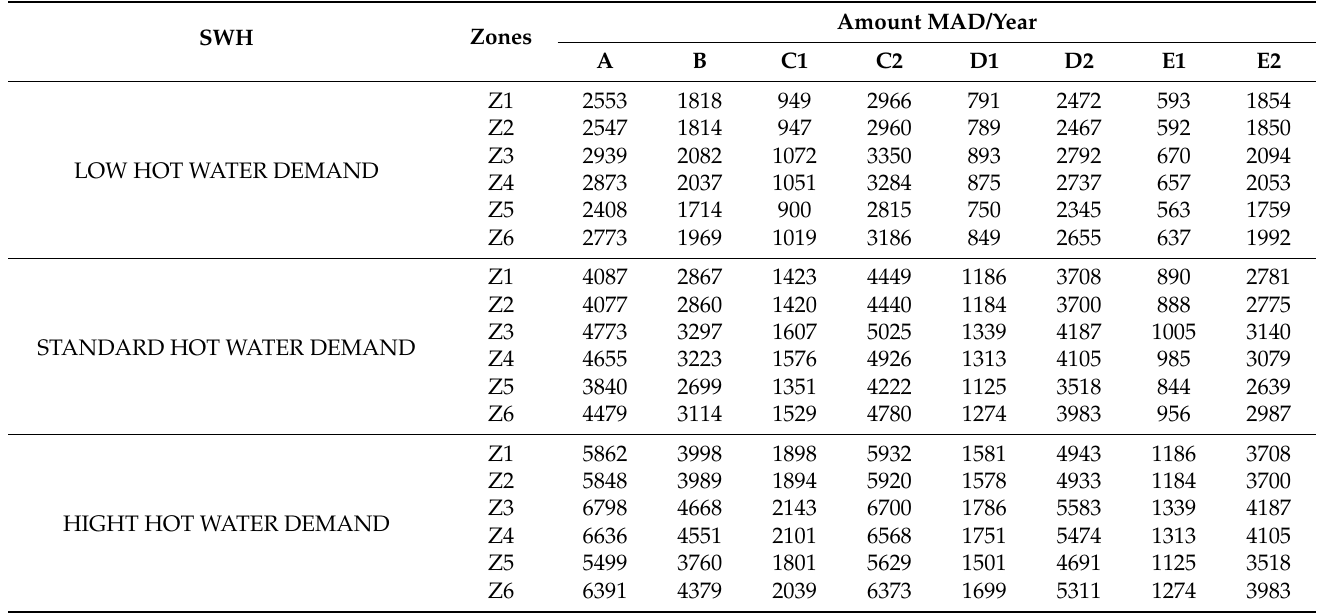
Table 13. Annual invoice for hot water conventional systems production.